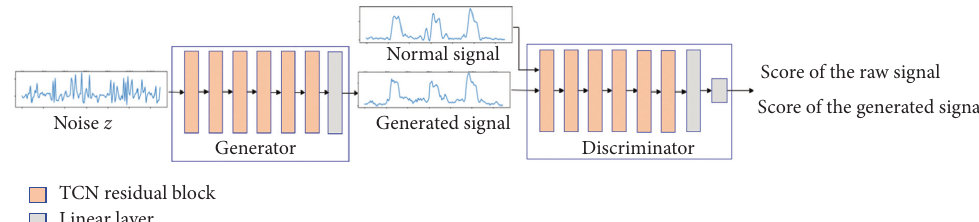
Figure 3: The schematic diagram of the MI-GAN architecture. The generator projects the random noise space to the normal signal space, and the discriminator calculates the final fake-level scores of the abnormal signals.